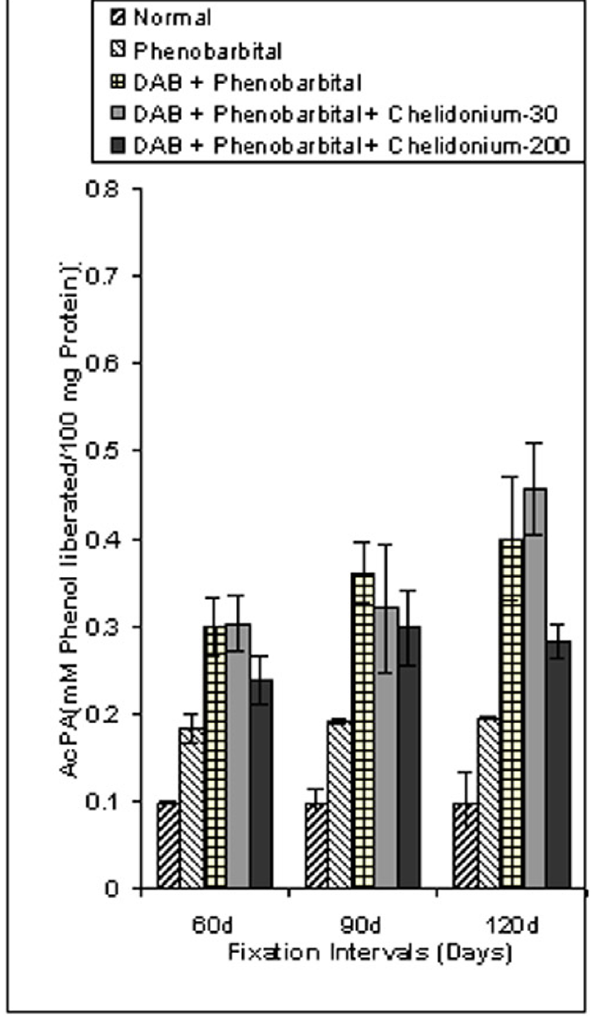
Figure 8 Showing acid phosphatase activity in liver of experimental mice at different fixation